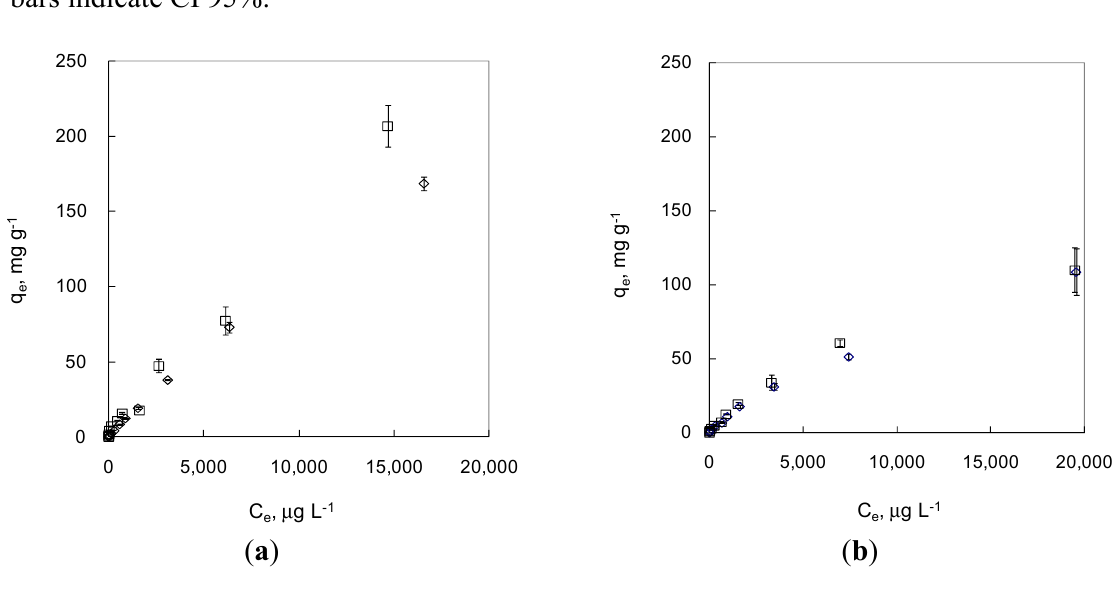
Figure 2. Adsorption of As(III) and As(V) by MNP under anaerobic ( a ) and aerobic ( b ) conditions. Empty rhombus represents As (III) and empty square represents As(V). Error bars indicate CI